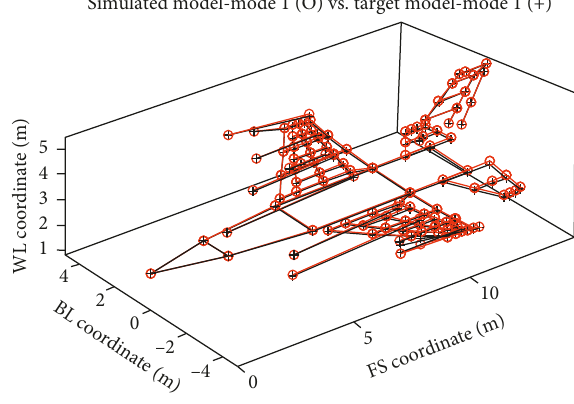
Figure 22: Mode shape for configuration 5 mode-1.